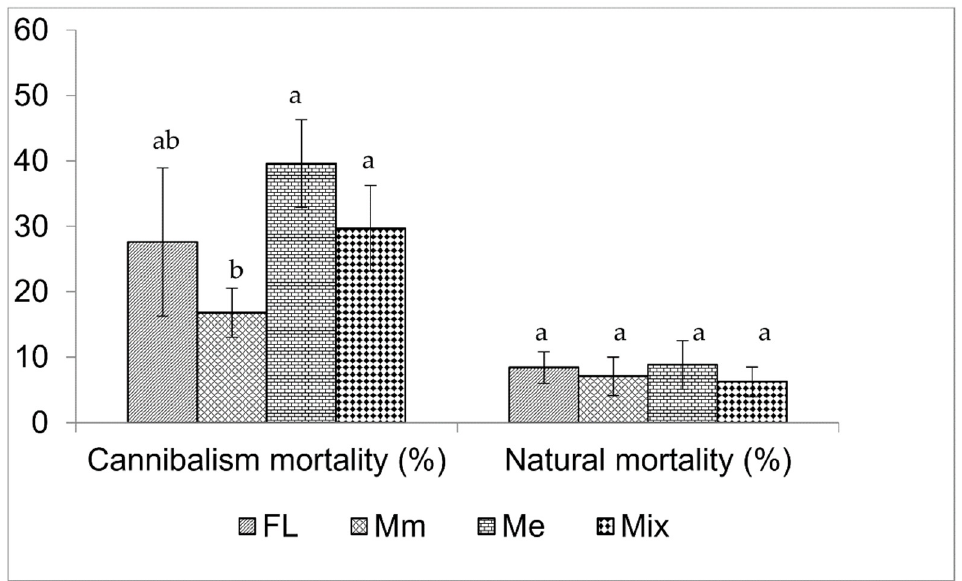
Figure 2. Mortality of larvae of dorada Brycon sinuensis fed different live prey. Different letters indicate significant difference (p < 0.05). Forage larvae of Piaractus brachypomus (F L ); Moina minuta (Mm); Macrothrix elegans (Me); mixture (50:50) of the Moina minuta and Macrothrix elegans (Mix). Table 1. Weight gain (W G ), length gain (L G ), and specific growth rate (G) of dorada Brycon sinuensis larvae after receiving different feeding prey for 24 h. Forage larvae of Piaractus brachypomus (F L ); Moina minuta (Mm); Macrothrix elegans (Me); mixture (50:50) of the Moina minuta and Macrothrix elegans (Mix).